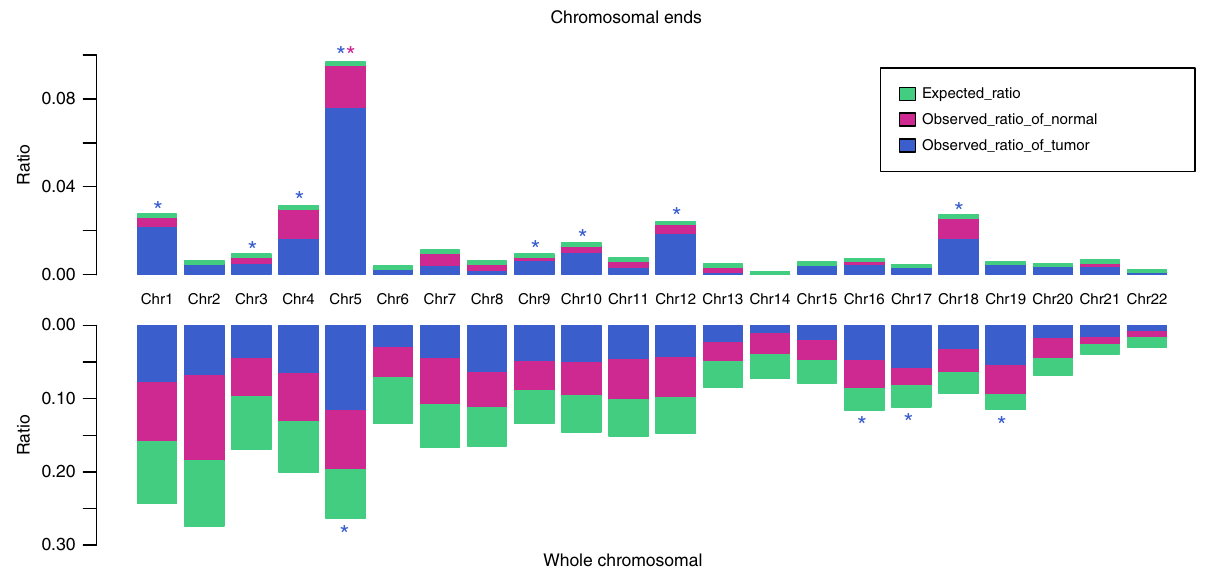
Figure 2 | Chromosome enrichment and chromosomal ends enrichment of HBV integration in human genome in 426 paired samples. Each bar of whole-chromosome represents the expected (assuming uniform, random distribution, green) and the observed (actual numbers, tumour: blue, normal liver tissue: purple) ratio of HBV integration breakpoints at a particular chromosome in human genome. Ratios are numbered. Each bar of chromosomal ends represents the expected (assuming uniform, random distribution, green) and the observed (actual numbers, tumor: blue, normal liver tissue, purple) ratio of HBV integration breakpoints at the 2M region of chromosomal ends in human genome. Ratios are numbered. Dark red star represents statistically significant difference between normal liver samples and random distribution. Blue star represents statistically significant difference between tumour samples and random distribution. P values were calculated by w 2